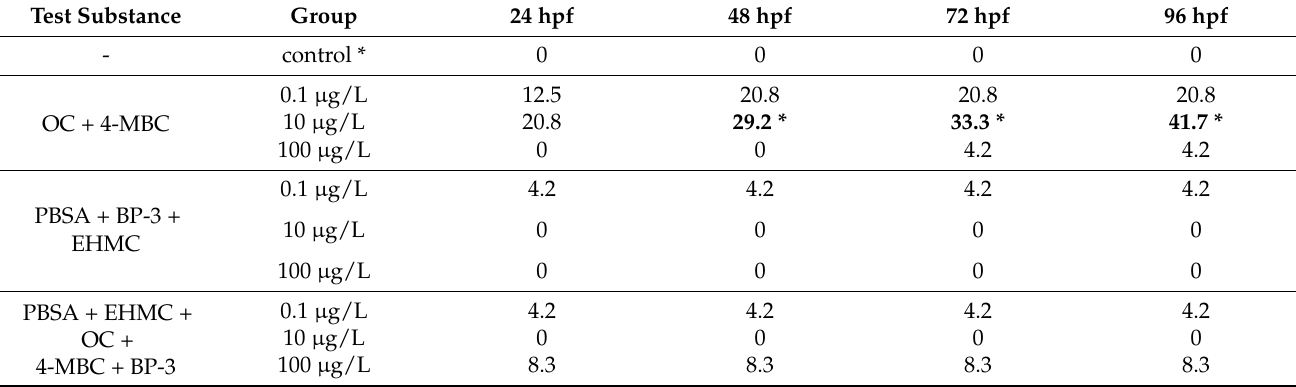
Table 1. Cumulative mortality (%) of zebrafish embryos exposed to various mixtures of UV filters during 96 h. The bold font and asterisk indicate a significant difference ( p < 0.05) between the control and experimental groups at the same time of exposure. *—no mortality was observed in both control group and control groups with